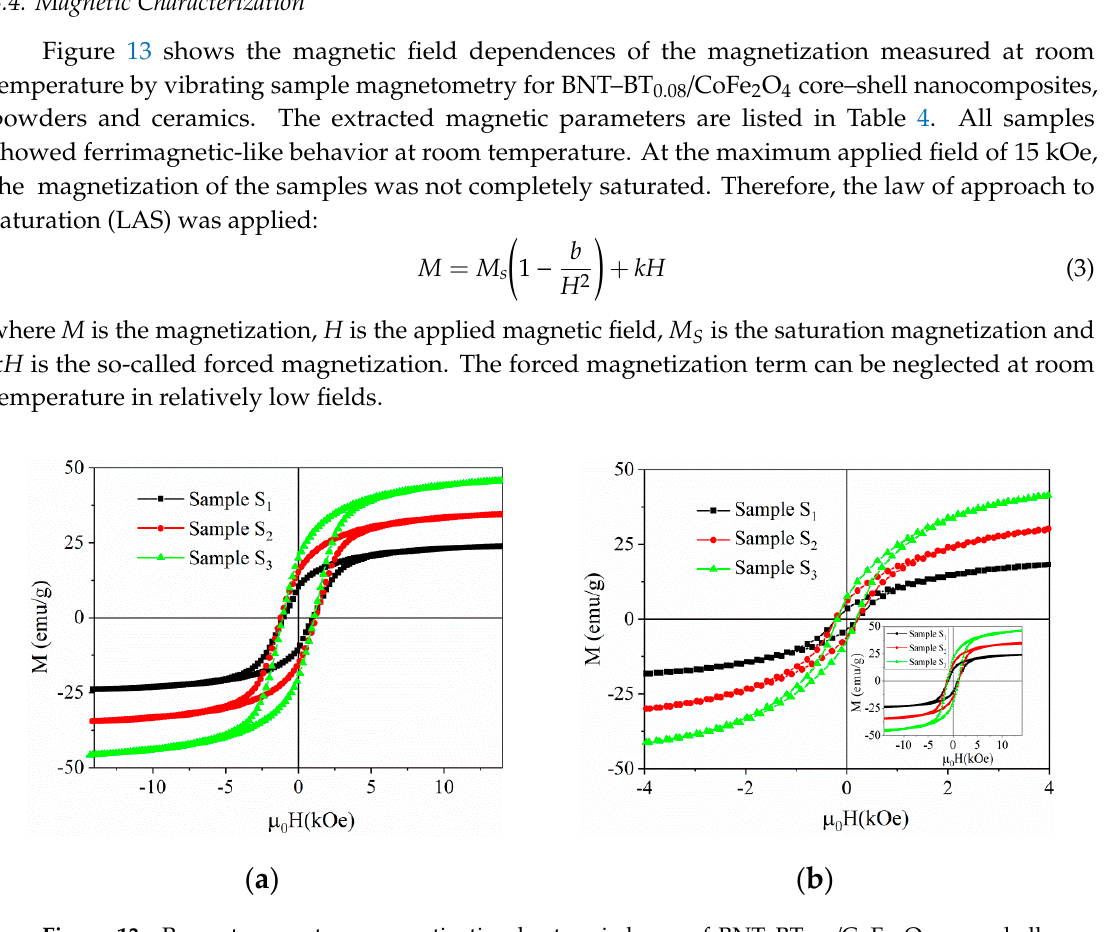
Figure 13. Room temperature magnetization hysteresis loops of BNT–BT 0.08 /CoFe 2 O 4 core–shell powders ( a ) and ceramics ( b ) in 1:0.5, 1:1 and 1:1.5 molar ratios (sample S 1 , sample S 2 and sample S 3 ). The inset of ( b ) shows an extended view of the corresponding hysteresis curves. Table 4. Magnetic properties, measured at room temperature for the BNT–BT 0.08 / CoFe 2 O 4 core–shell powders and ceramics.